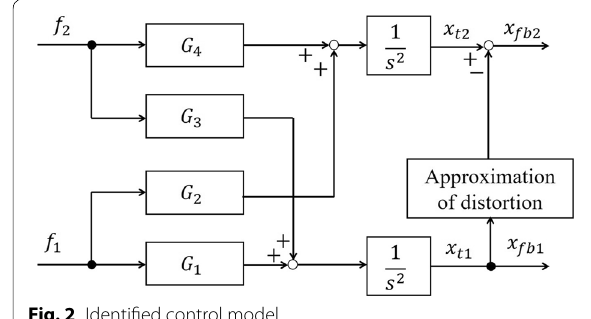
Fig. 2 Identified control model